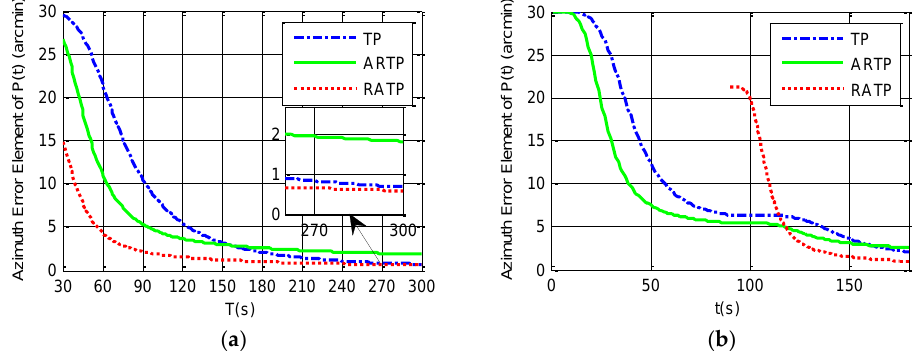
Figure 2. Simulation results under angular vibrations with an amplitude of 5 arcsec and a random frequency between 5 and 10 Hz. ( a ) 1 − σ final azimuth error when the total alignment time T changes from 30 to 300 s. ( b ) Azimuth error curve when the total alignment time is 180 s.